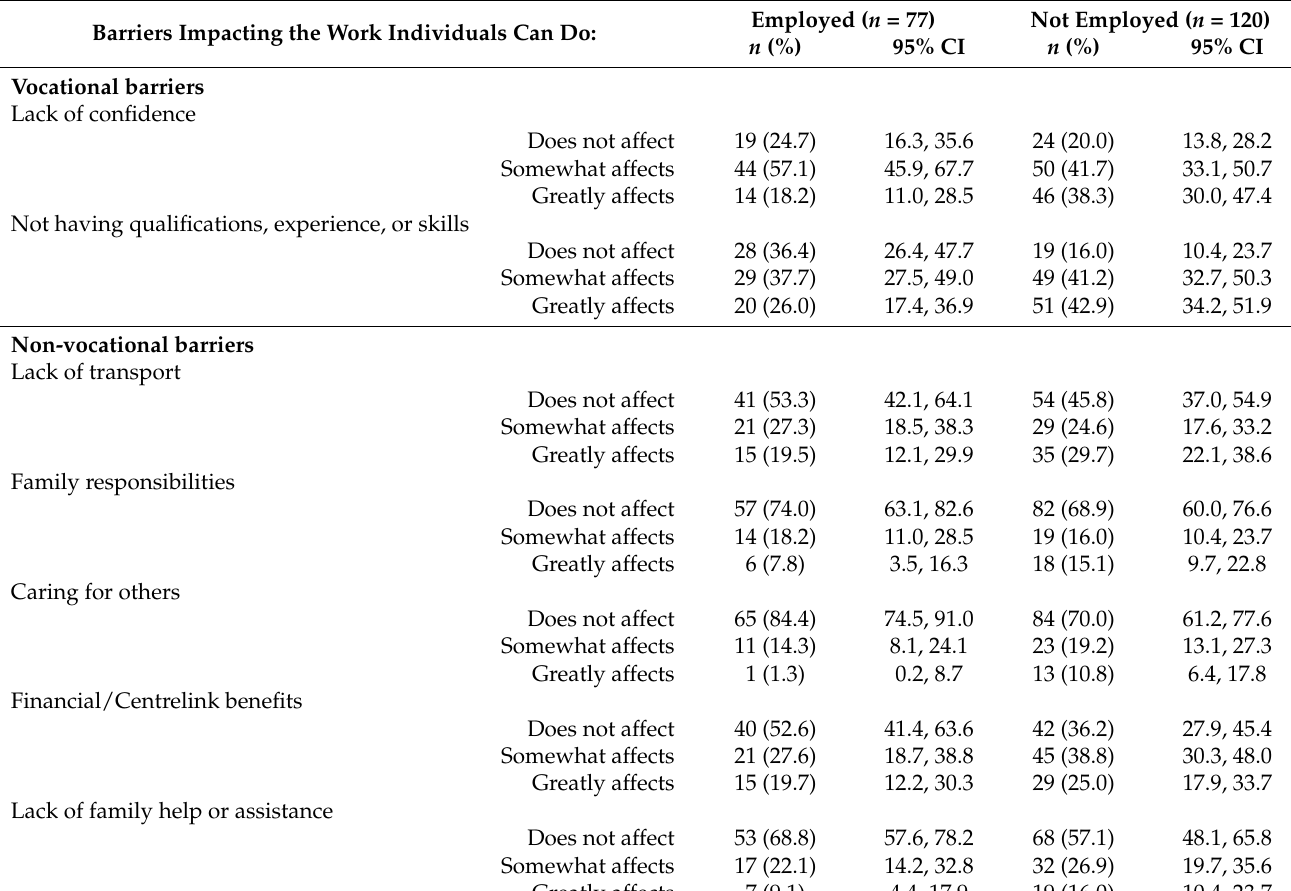
Table A2. Wave 1 Barriers by Wave 2 employment